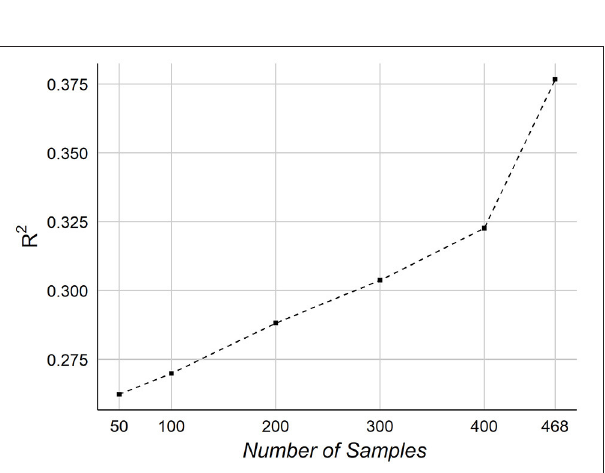
FIGURE 10 | The effect of the number of samples on the age